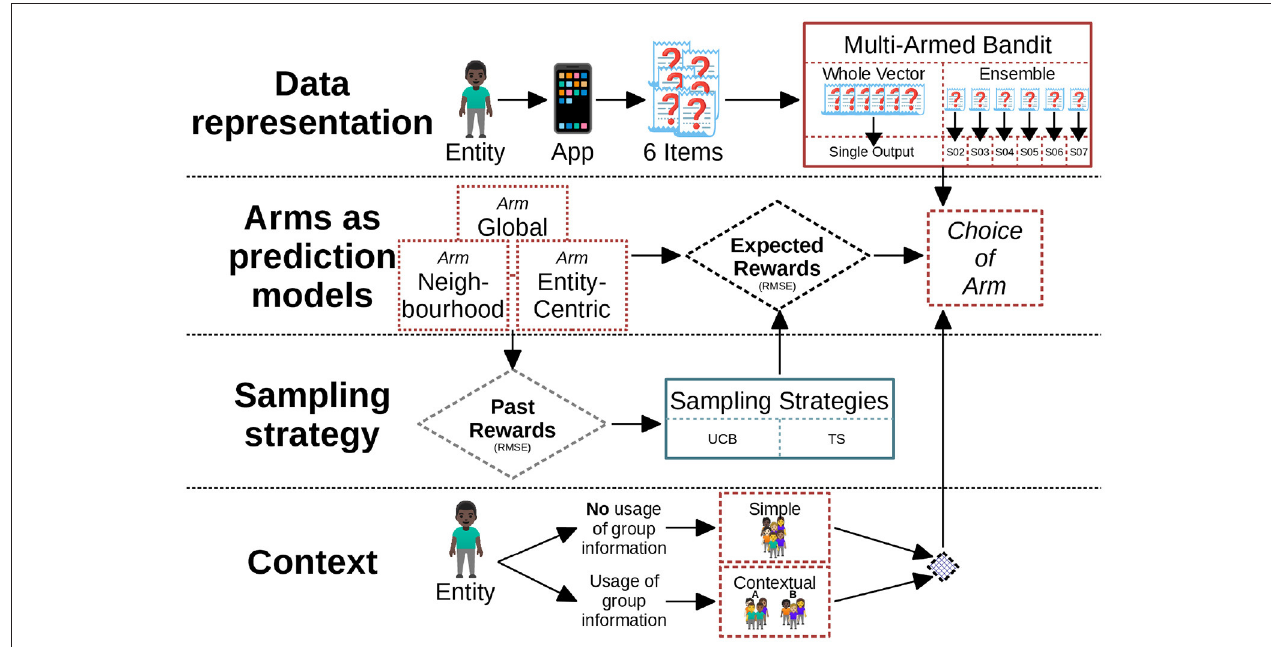
FIGURE 1 | The figure shows the outline of the system used to predict the answers given by the entities. The entire architecture is divided into 4 main parts. The first part shows the representation of the data and the output. The second part is about the prediction models as the arms of the bandit followed by the sampling strategies and the context for the bandit. We have both ensemble and whole vector bandit for each contextual and simple bandits. RMSE here refers to root mean square